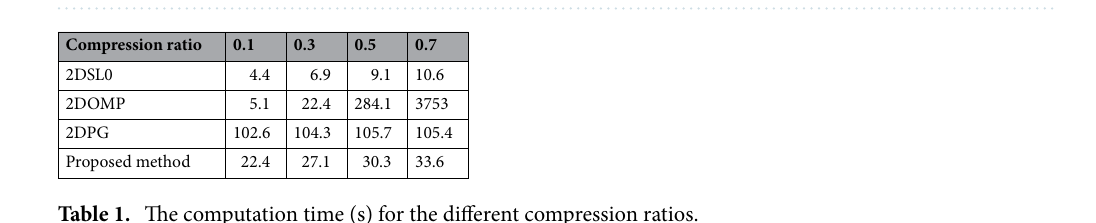
Figure 4. Performance of the sparse reconstruction approaches with considering the effects of TV and chaotic confusion in the encryption process: The PSNR values of the decrypted test images for different CRs.